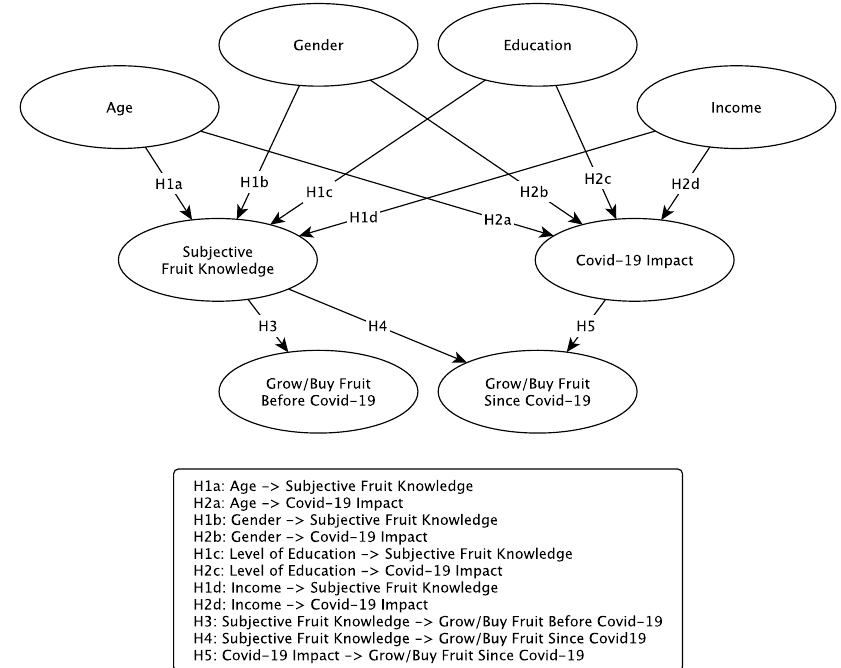
Figure 1. Conceptual Model and Proposed Hypotheses.